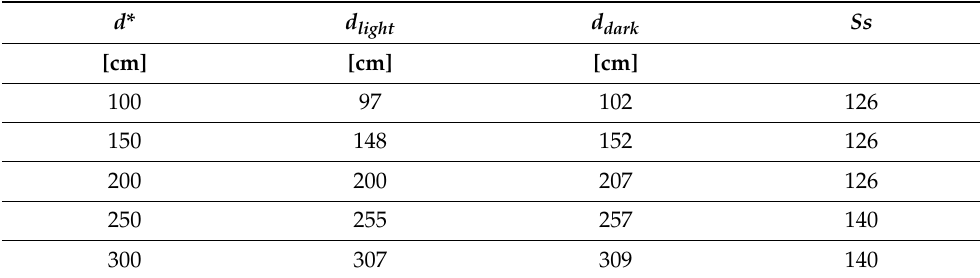
Table 10. Different color target experimental